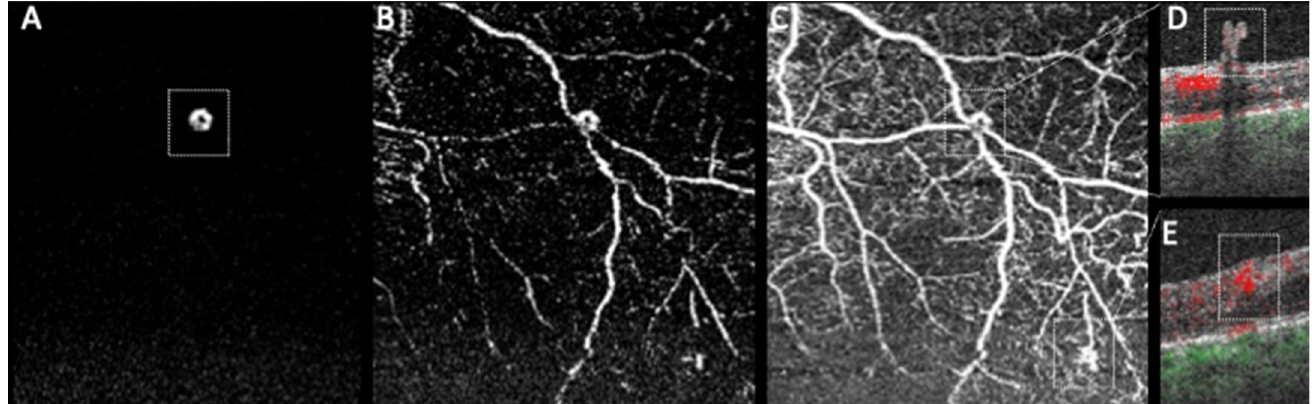
Figure 4. OCTA imaging of a small NVE. Note the presence of a vascular signal in the automated vitreoretinal slab ( A ), indicating the NVE (annotated). With manual segmentation ( B ), some vessels of the superficial plexus can be observed better localizing it. ( C ) is segmented between the vitreous and the inner retina and now, besides the NVE (top box), another lesion can be observed (bottom box). Corresponding B-scans show that the top lesion is indeed an NVE with ILM breaching ( D ), while the bottom lesion corresponds to an IRMA ( E